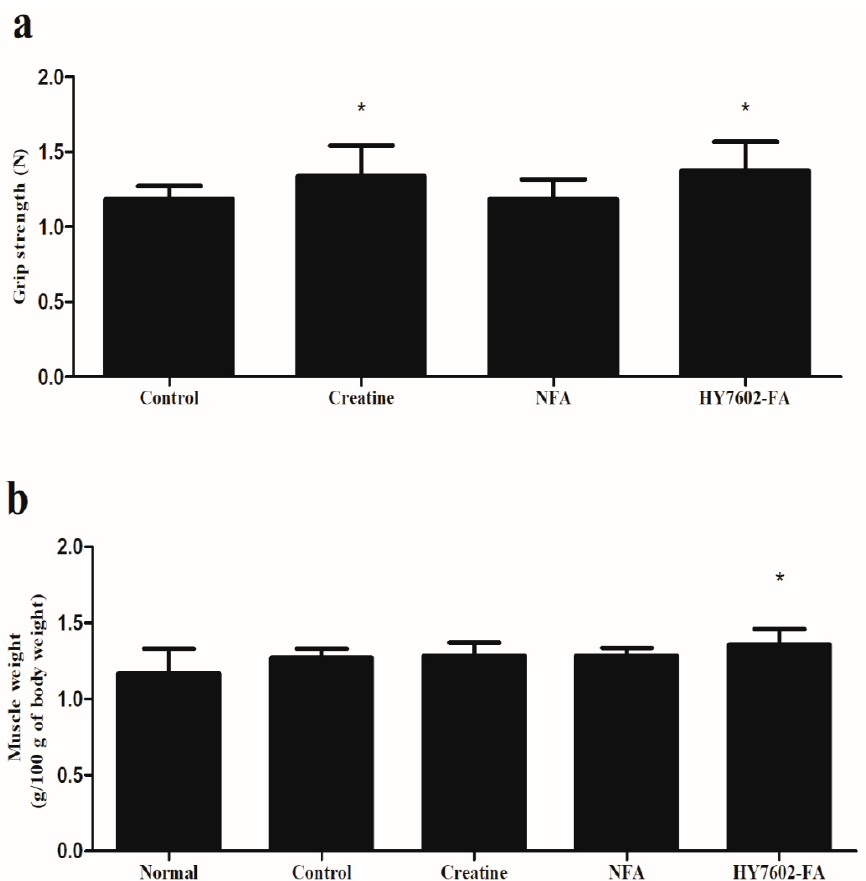
Figure 5. Effect of HY7602-FA on grip strength and skeletal muscle mass. Forelimb grip strength was measured using a grip strength meter equipped with a T-shaped pull bar. Each mouse performed three consecutive tests to obtain the peak value ( a ). Ratio of skeletal muscle mass (soleus, EDL, and gastrocnemius muscles)/bodyweight increases after HY7602-FA intake ( b ). Data are expressed as the mean ± SD ( n = 9 mice per group), and asterisks indicate significant differences: * p < 0.05 and ** p < 0.01 vs. the control group. NFA, non-fermented antler; FA, fermented antler. Overall, these data suggest that HY7602-FA improves grip strength by inducing muscle